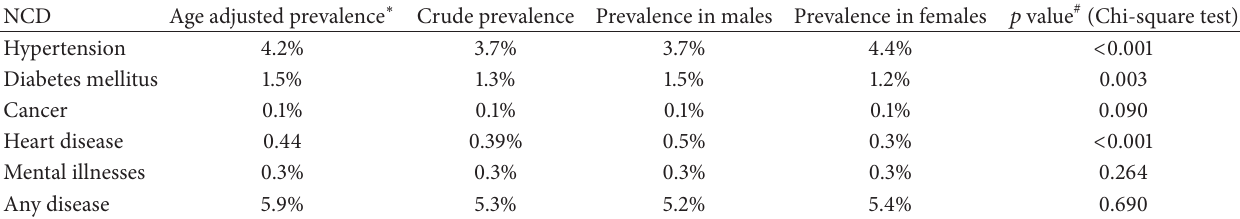
Table 3: Prevalence of self-reported noncommunicable diseases (NCDs) in the adult population (aged 20–69 years).